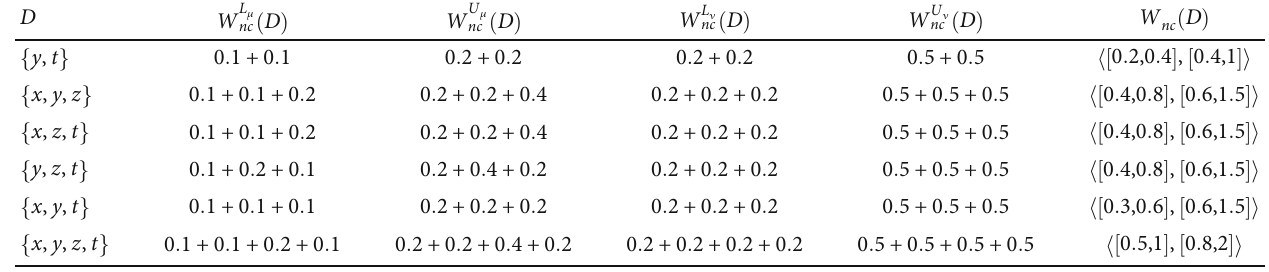
Table 2: Calculating the weight of SISs.